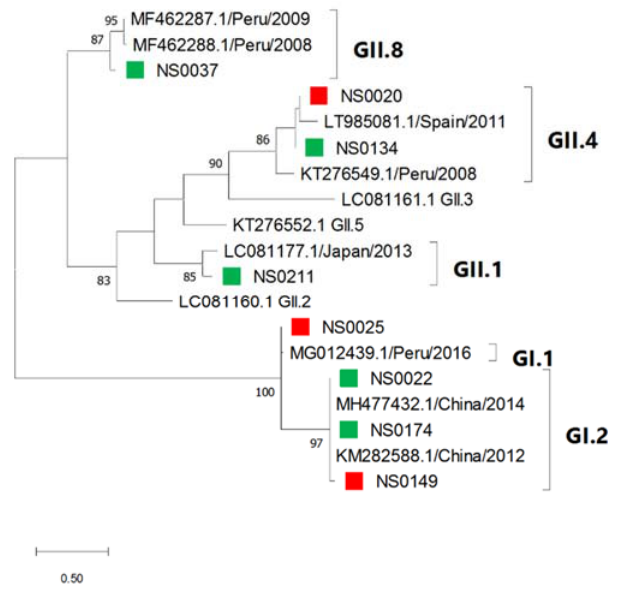
Figure 7. Sapovirus genotypes identified by maximum likelihood phylogenetic analysis of the partial capsid gene (207 bp) of sapovirus strains detected in children hospitalised with gastroenteritis at KPTH between July 2016 and December 2017. Closely related strains from GenBank were included. Bootstrap support of >70% is shown. The scale bar represents 0.5 nucleotide substitutions per site. Secretor status of infected child is indicated by green (secretor) and red (non-secretor) blocks.